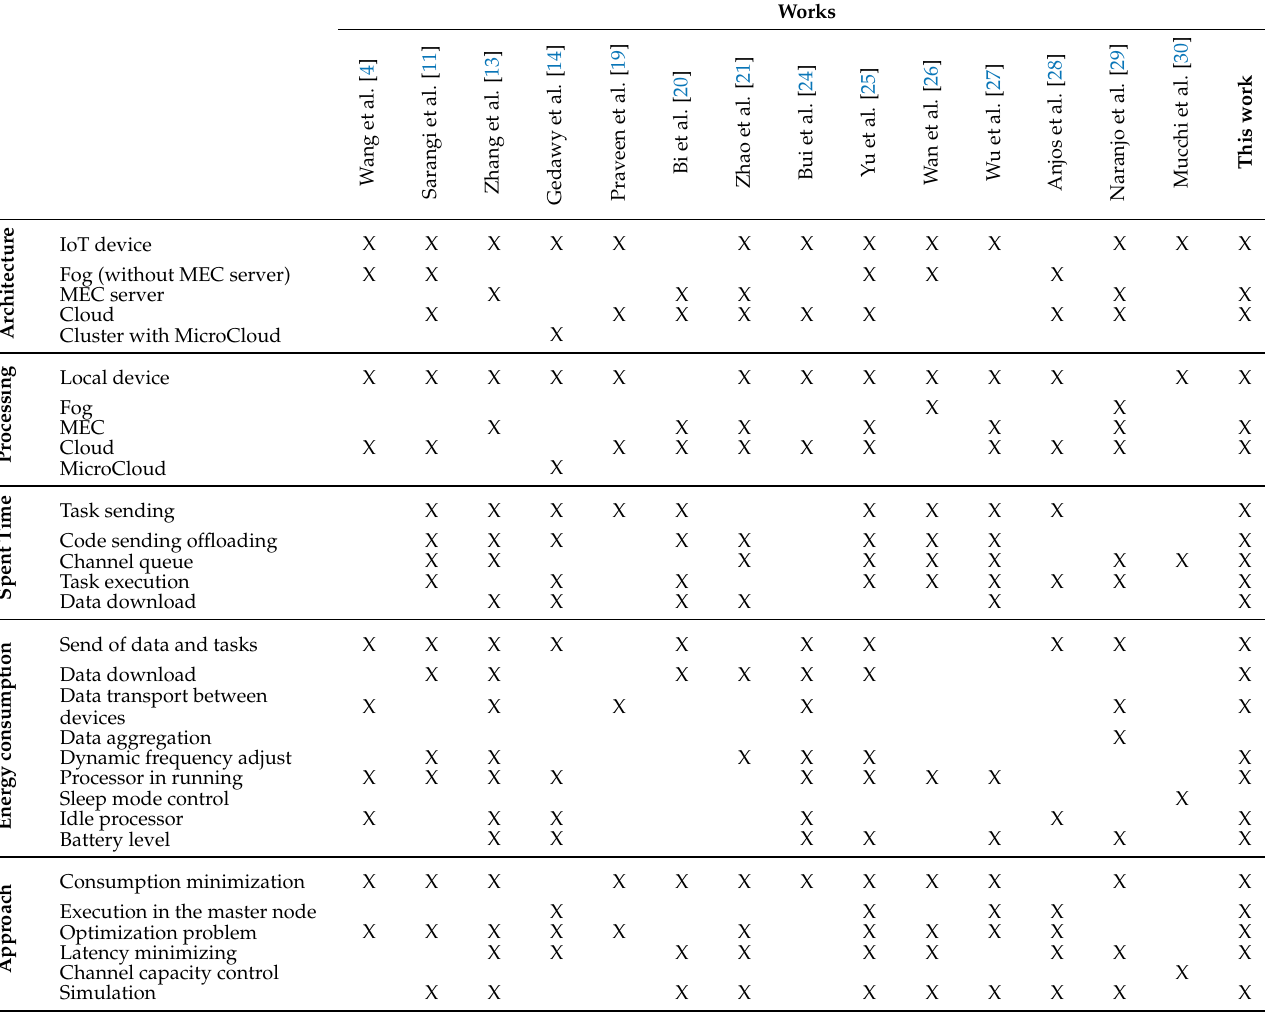
Table 1. Proposal